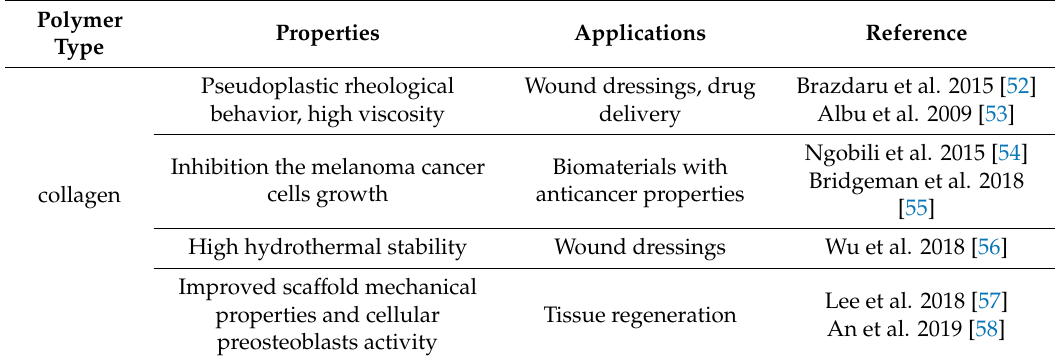
Table 3. Summary of tannic acid-based biomaterials—their properties and